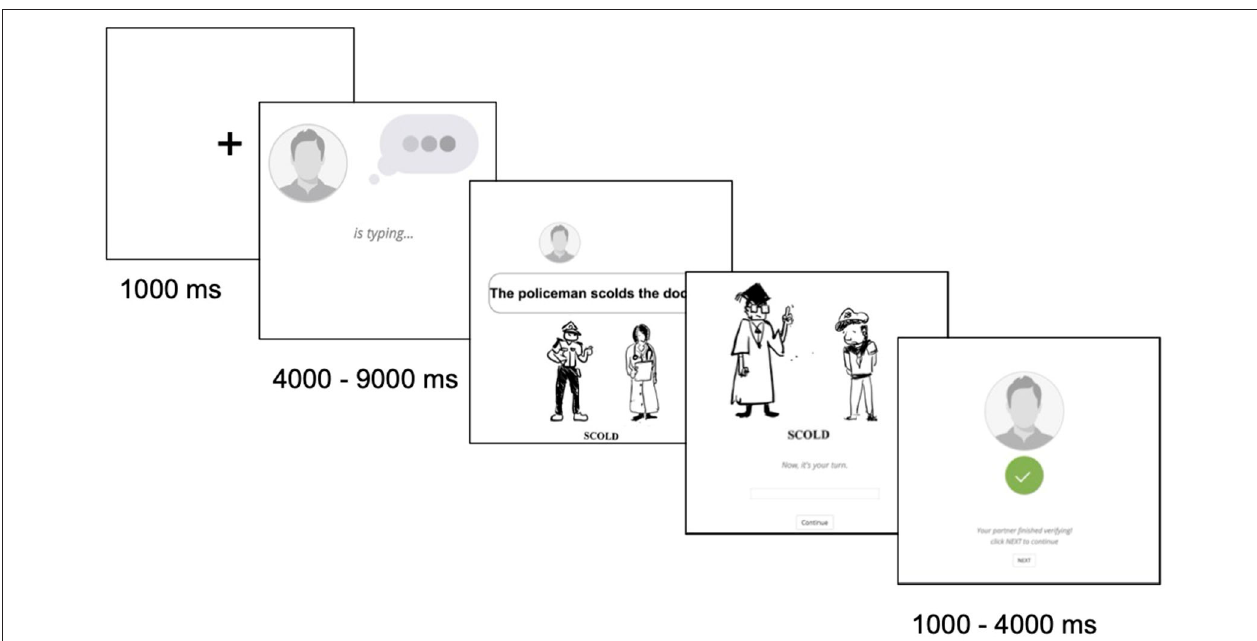
FIGURE 2 | An example trial of Experiment 1, including a verification task and a description task. Verification task: an online “partner” (confederate) was typing a sentence to describe the picture shown below. Participants needed to verify whether the sentence and the picture matches. Picture description task: participants typed a sentence to describe the picture and waited for the “partner” to verify the response. The picture stimulus is only for demonstration purpose, not the real ones used in the